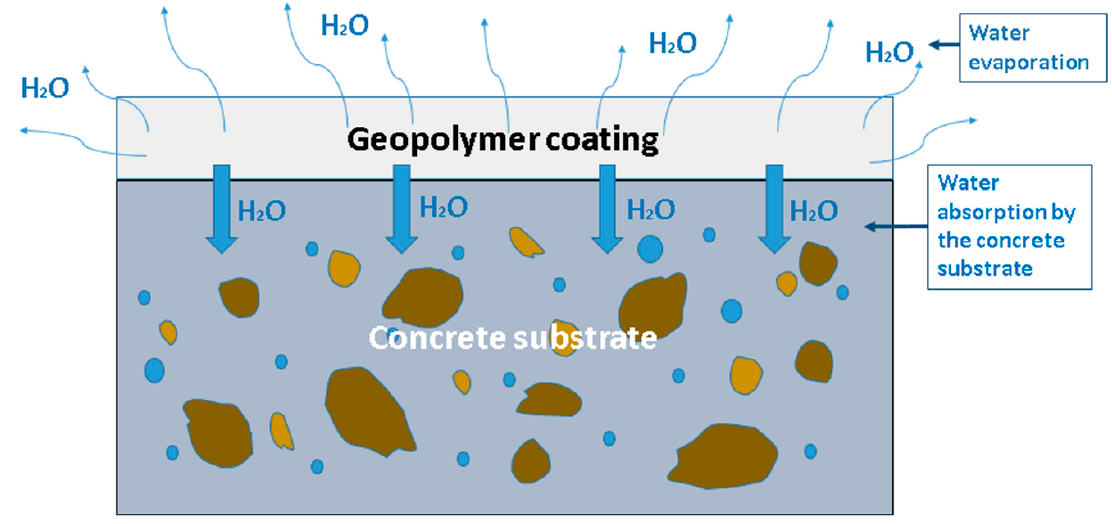
Figure 1. Illustration of the main water loss mechanisms from geopolymer coatings on concrete substrates.